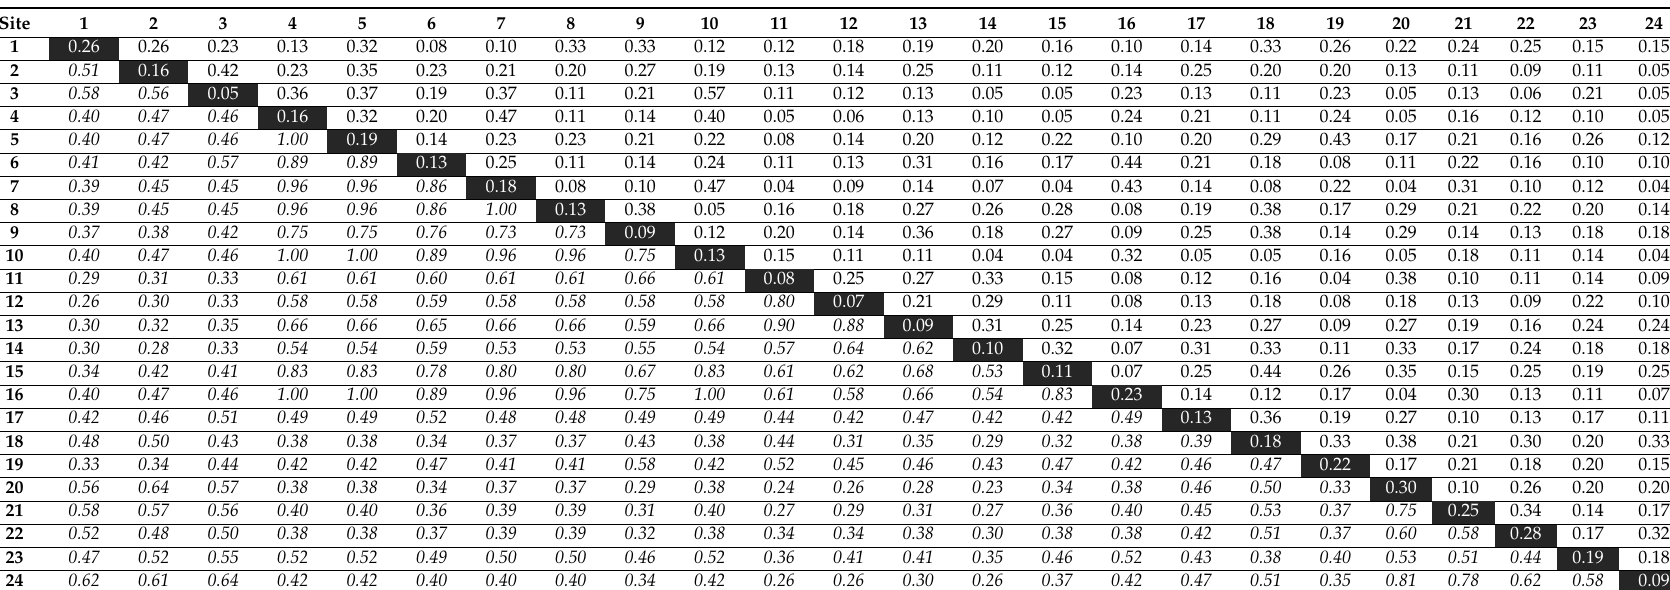
Table 1. Jaccard’s similarities index of fish fauna composition in the Min River. Italic numbers in bottom-left were similarities between paired sites in 1970s; numbers in upper-right were similarities between paired sites in 2015; numbers in black grids were similarities between the same sites in two